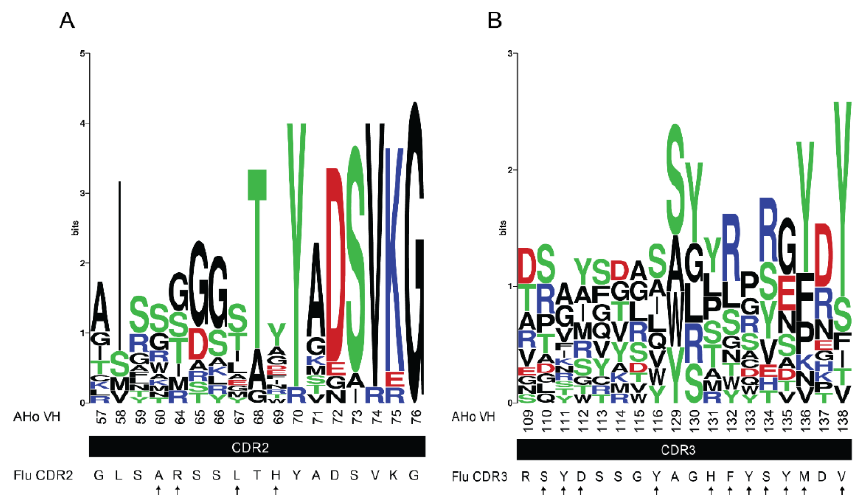
Figure 4. CDR2 and CDR3 sequence logos of protein- and hapten-specific VHH. Eight hapten- and nine protein-binding VHH were aligned to generate sequence logos of CDR2 ( A ) and CDR3 ( B ). The fluorescein-specific CDR sequences are shown below the graphs. The numbering scheme is according to AHo [54]. Residues that were chosen for randomization are marked by arrows. The sequence logos were generated with WebLogo [53].